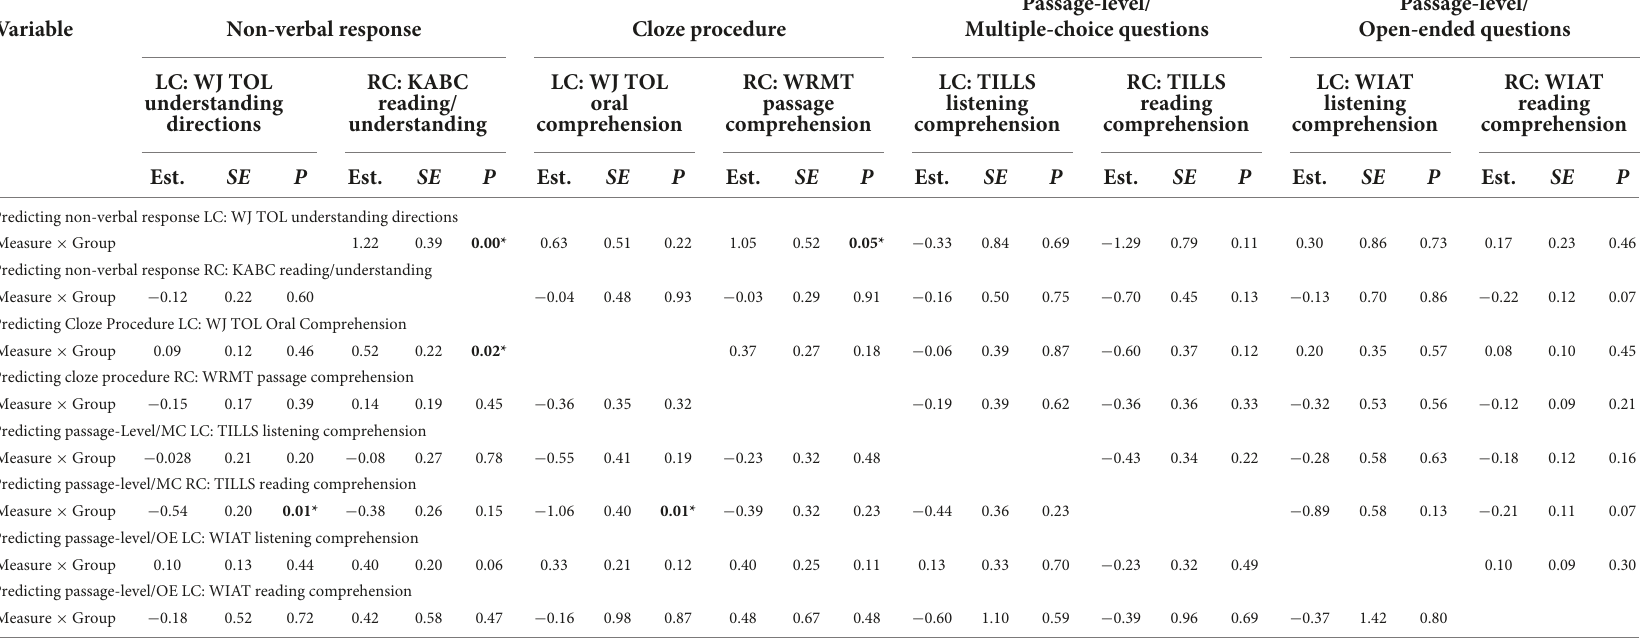
TABLE 6 Regression coefficients predicting each listening comprehension and reading comprehension